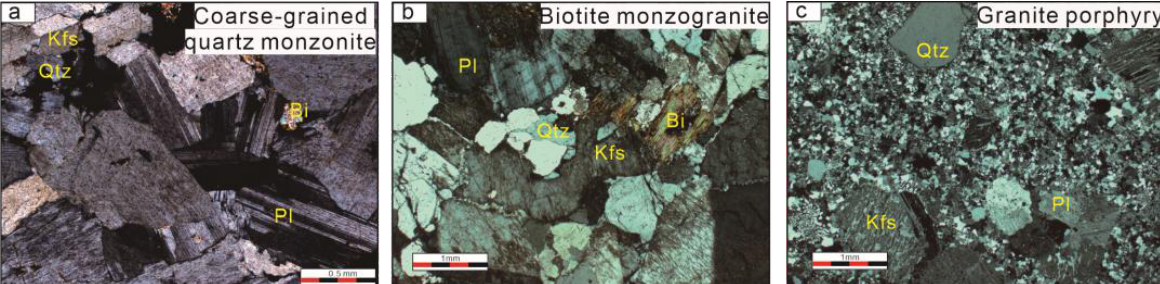
Figure 2. Major mineral assemblages of the ( a ) coarse-grained quartz monzonite, ( b ) biotite monzogranite, and ( c ) granite porphyry in the Yushulinzi pluton. Kfs, K-feldspar; Pl, plagioclase; Qtz, quartz; Bi, biotite.